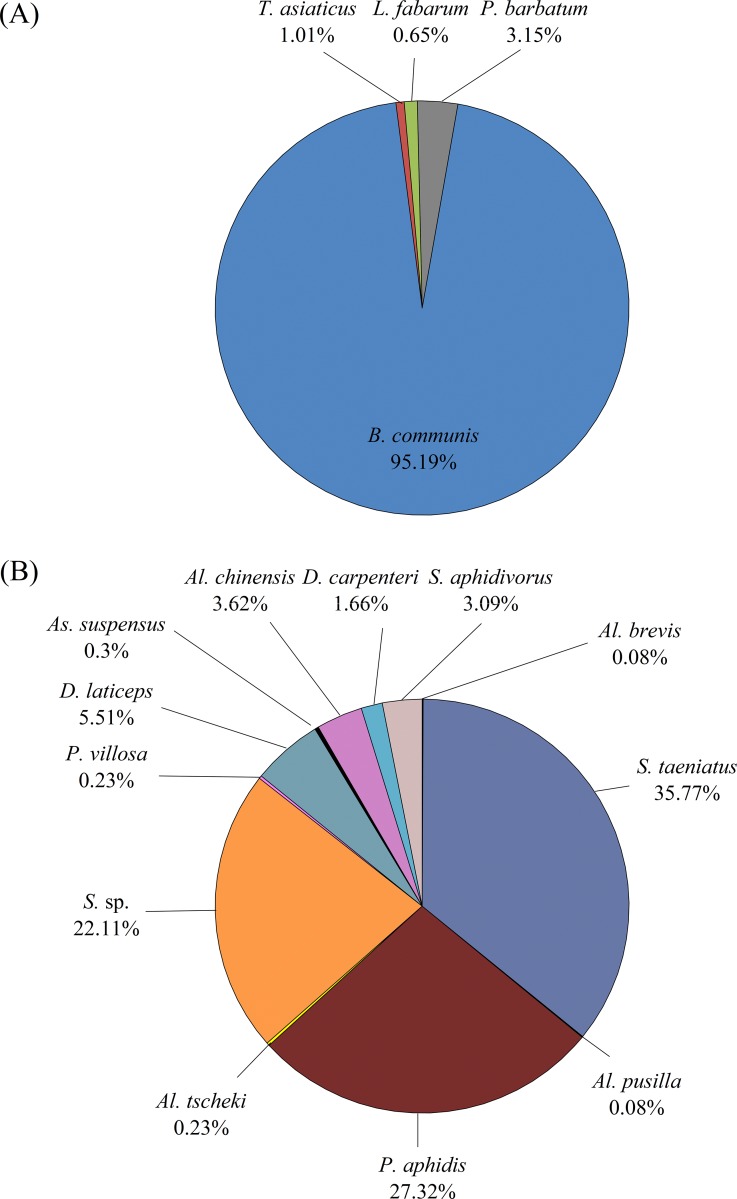
The composition of the primary parasitoids (A) and hyperparasitoids (B) associated with the cotton aphids in Xinjiang, China, in 2015–2017. Note: short name for the different primary parasitoids and hyperparasitoid species. Primary parasitoids: B. communis: Binodoxys communis; L. fabarum: Lysiphlebus fabarum; T. asiaticus: Trioxys asiaticus; P. barbatum: Praon barbatum. Hyperparasitoids: Al. brevis: Alloxysta brevis; Al. chinsensis: Alloxysta chinensis; Al. tscheki: Alloxysta tscheki; D. carpenter: Dendrocerus carpenter; D. laticeps: Dendrocerus laticeps; P. aphidis: Pachyneuron aphidis; S. aphidivorus: Syrphophagus aphidivorus; S. sp.: Syrphophagus sp.; S. taeniatus: Syrphophagus taeniatus; P. villosa: Phaenoglyphis villosa; As. suspensus: Asaphes suspensus; Al. pusilla: Alloxysta pusilla.